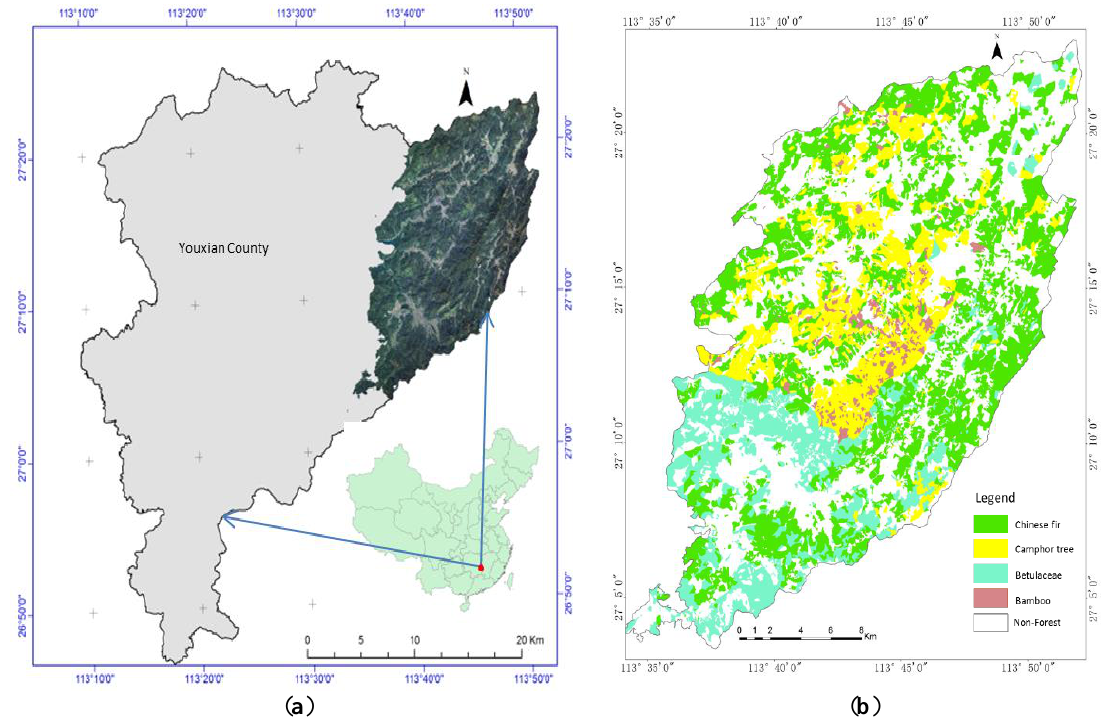
Figure 1. ( a ) Location of the study area and ( b ) the distribution of tree species in the study area.